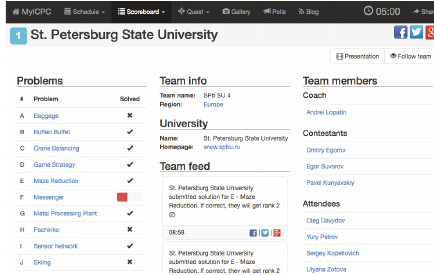
Figure 14: Team score statistics.